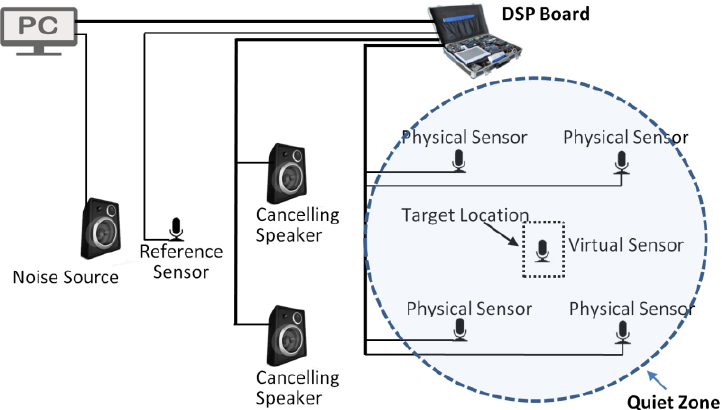
Figure 3. The multichannel ANC with virtual sensor.